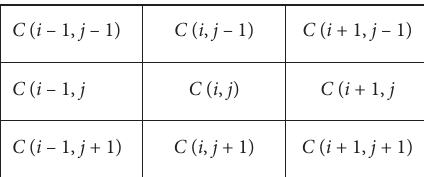
Figure 7: The eight neighboring